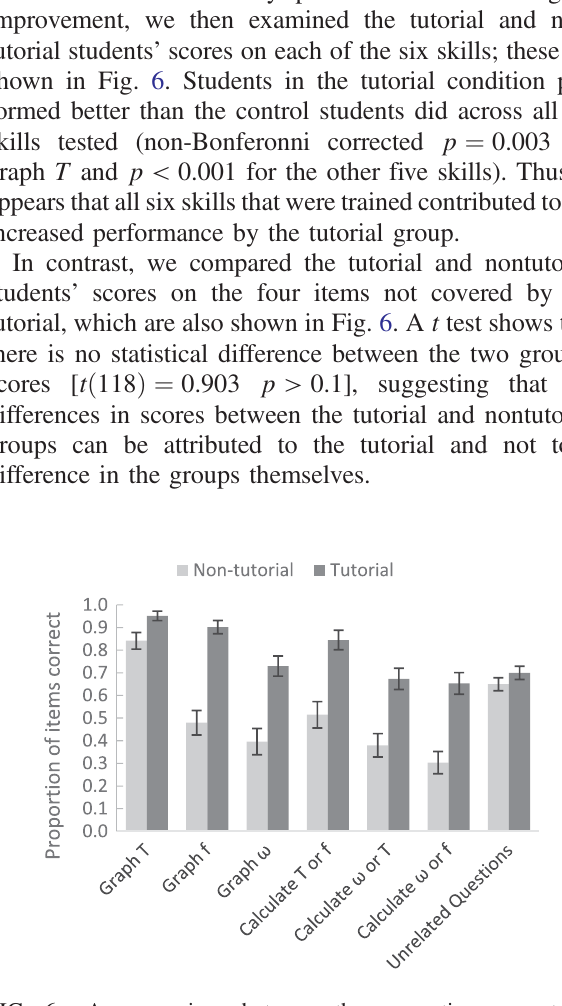
FIG. 6. A comparison between the proportion correct for tutorial students vs nontutorial students for each T , f , ω skill, and for four unrelated physics